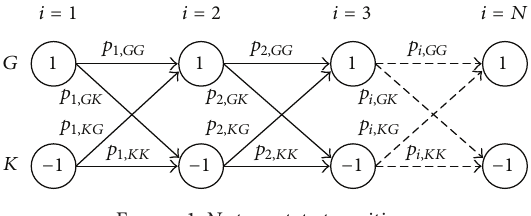
Figure 1: N steps state